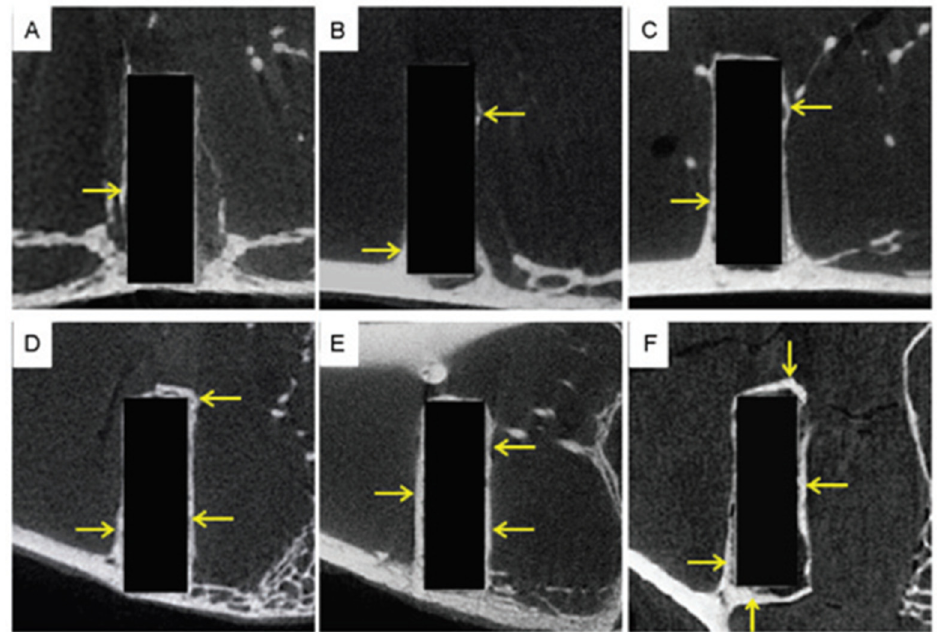
Figure 6. After blanking the previous ROI, a new larger ROI was selected (diameter = 2.5 and length = 6.5 mm) in the same shape and same position to observe new bone formation and assess the stimulatory effects of magnesium alloy on the growth of new bone tissue. New bone formed over time at different rates throughout the experiment. Representative micro-computed tomography images from ( A ) 1, ( B ) 4, ( C ) 12, ( D ) 24, ( E ) 36 and ( F ) 48 weeks are shown. Yellow arrows indicate new bone. Reprinted with permission from [188] (published under Creative Commons Attribution